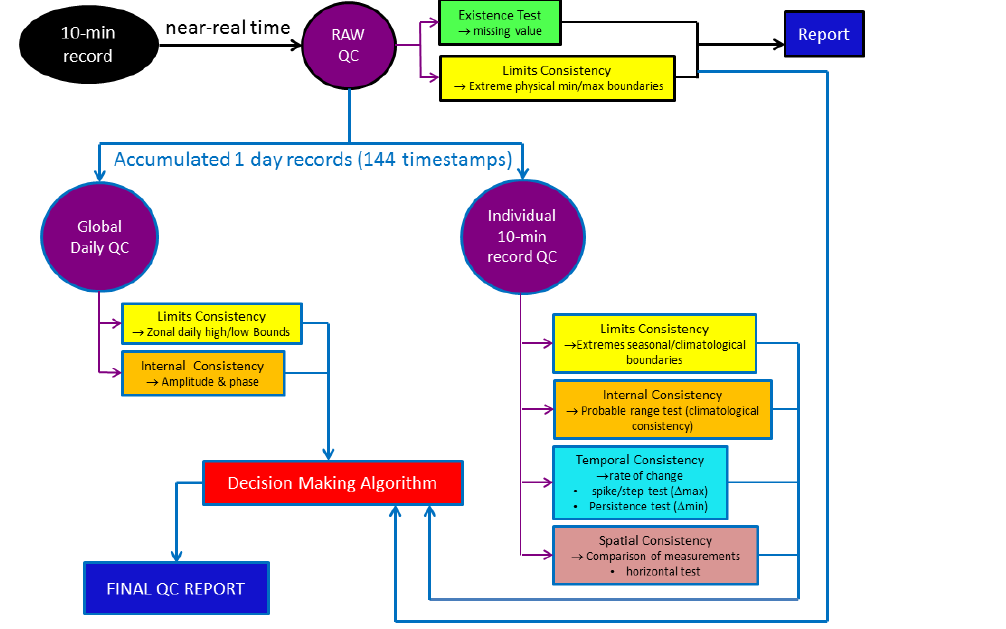
Figure 2. Complex QA of 10-min grass/soil temperatures